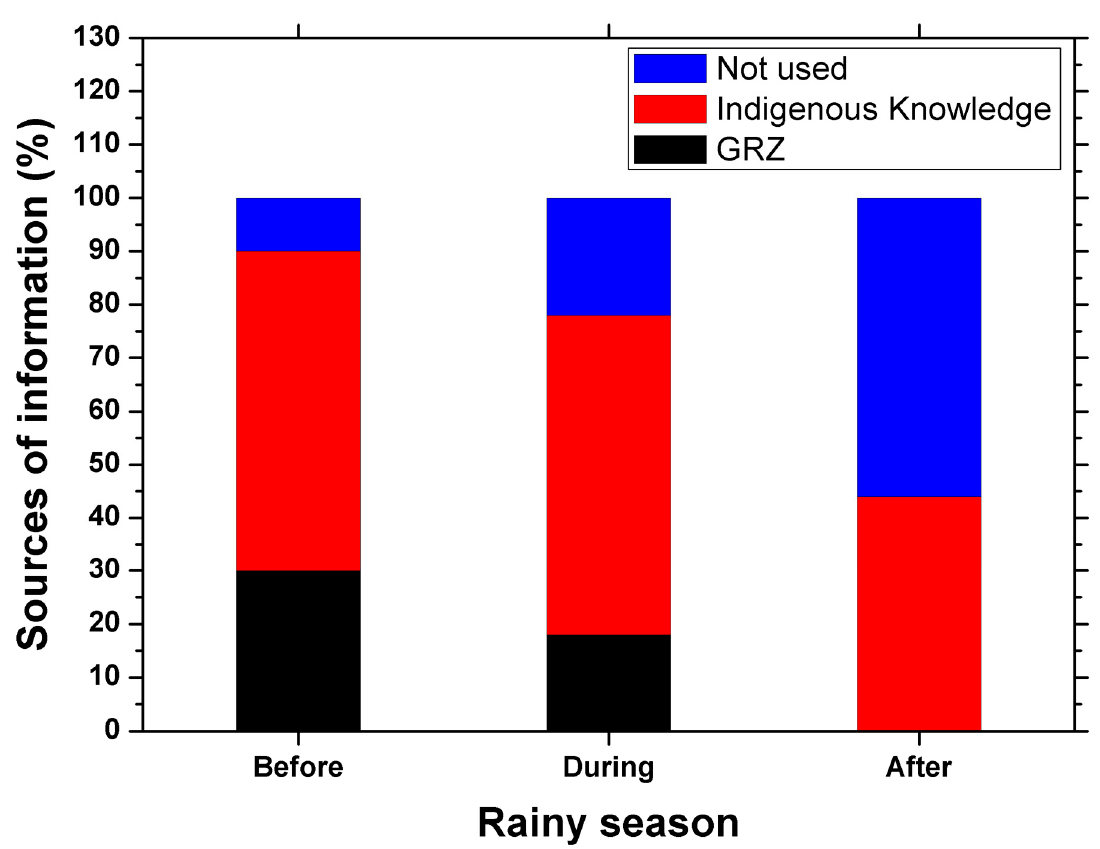
Figure 4. Sources of climate information used by respondents for disaster preparedness in the cereal value chain.